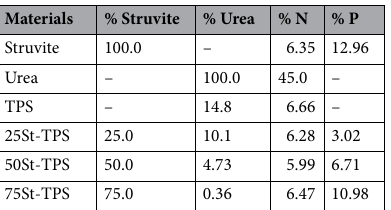
Table 2. Nutrient contents (wt%) of N and P in struvite, urea, pure TPS, and the St-TPS composites, as well as the percentages (wt%) of struvite and urea added to TPS-based materials.